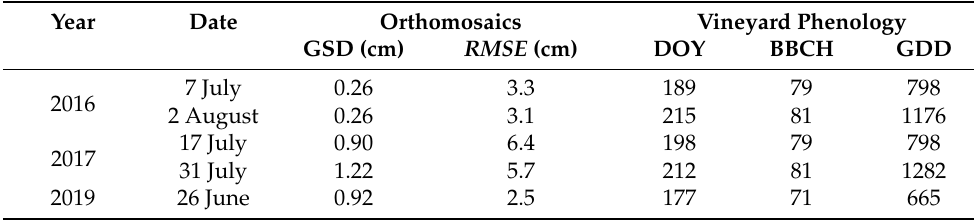
Table 1. The details of the flight surveys, ortho-mosaics’ properties, Ground Sample Distance (GSD), vineyard Day of the Year (DOY), BBCH, and Growing Degree Day (GDD)